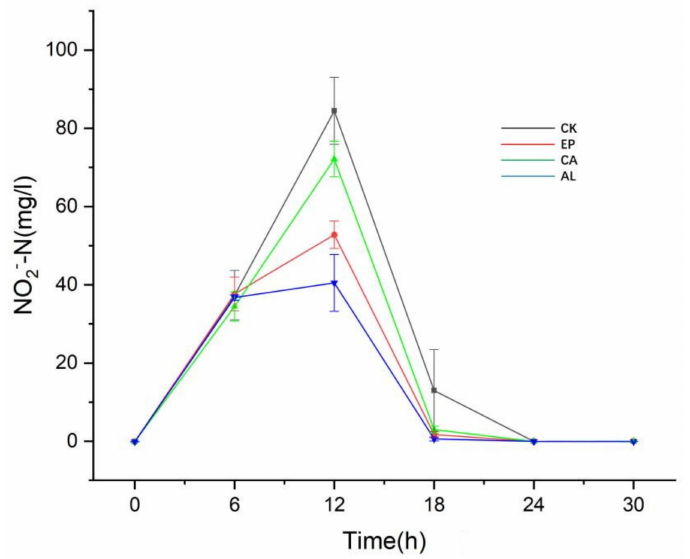
Figure 5. The changes of NO 2 − -N concentration with culture